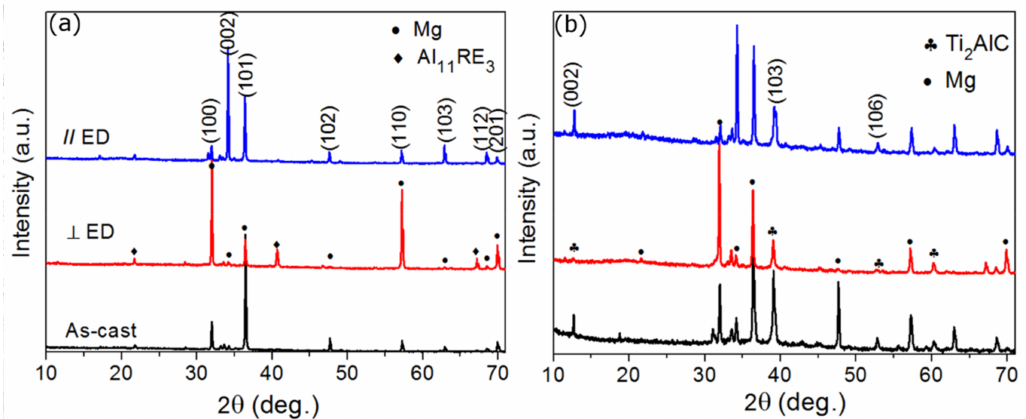
Figure 2. ( a ) and ( b ) XRD patterns of as-cast and hot-extruded AE44 and 15% Ti 2 AlC-AE44